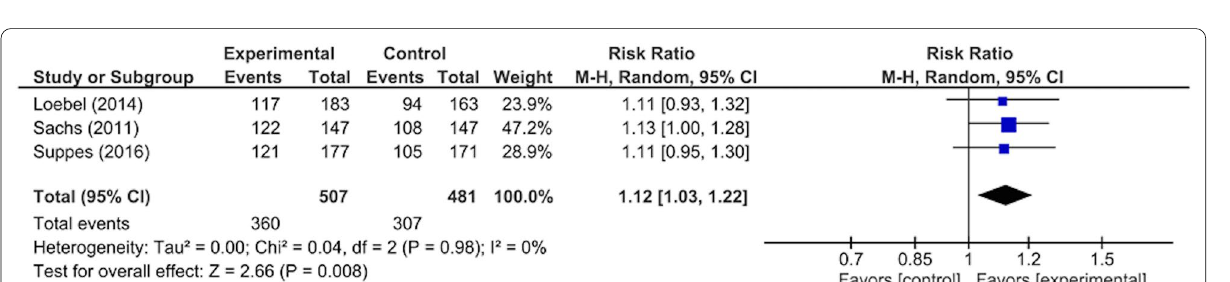
Fig. 6 Forest plot of post-intervention treatment effect sizes for rate of adverse events during study period . CI, confidence interval; SD, standard deviation; MS, mood stabilizers, including lamotrigine, lithium, and valproate; SGA, second-generation antipsychotics